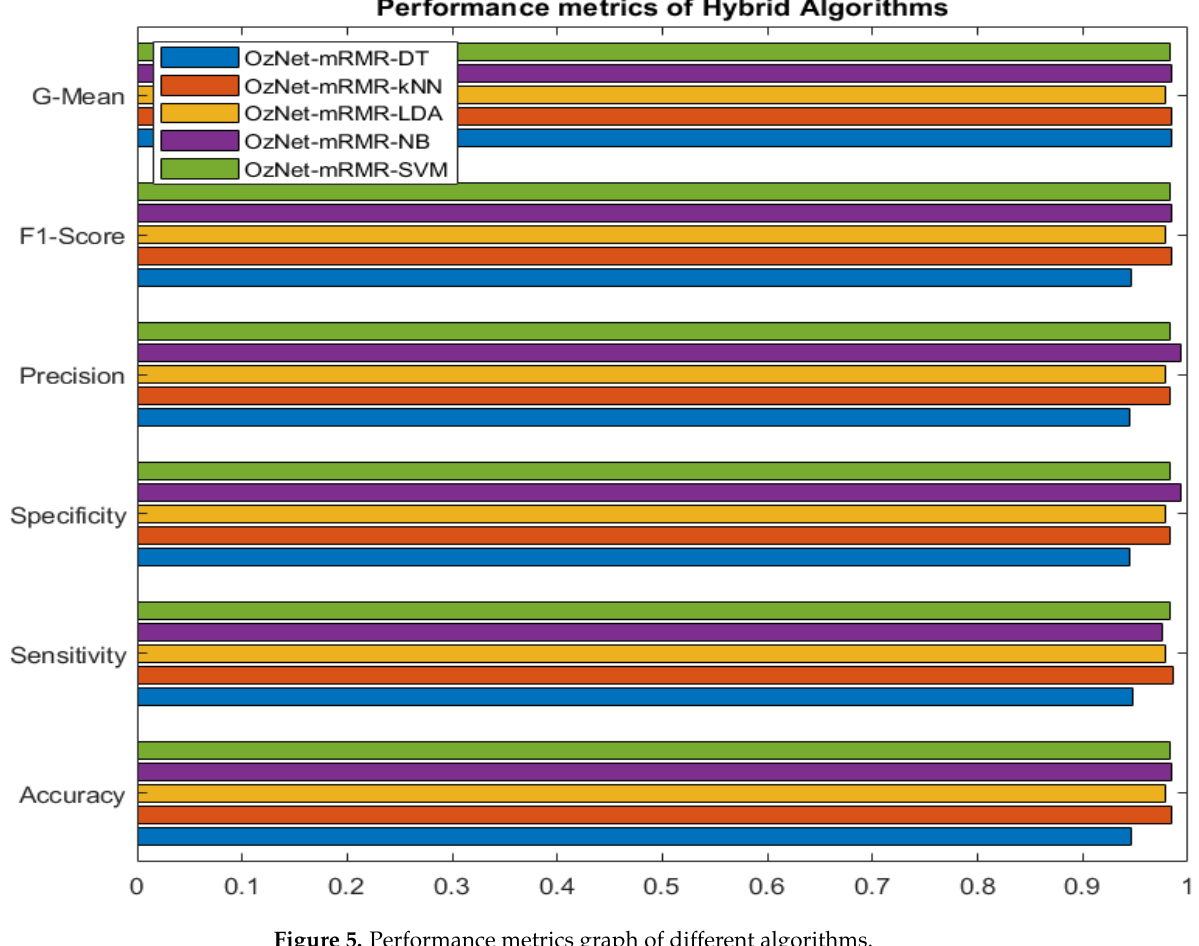
Figure 4. ROC Curves of OzNet hybrid algorithms.